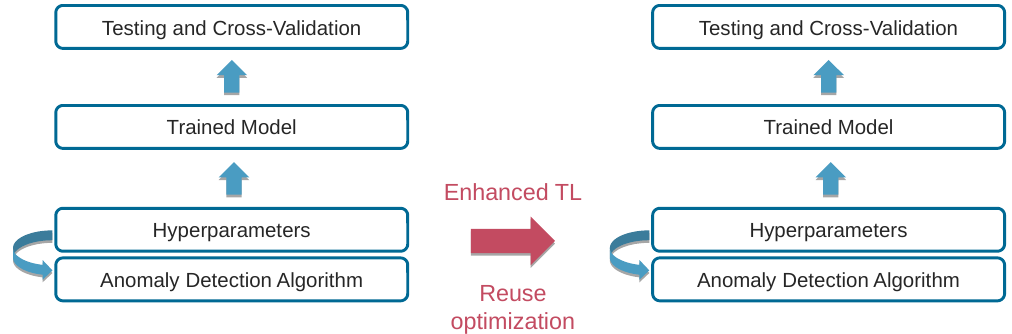
Figure 7. Transfer learning to speed up hyperparameter tuning and